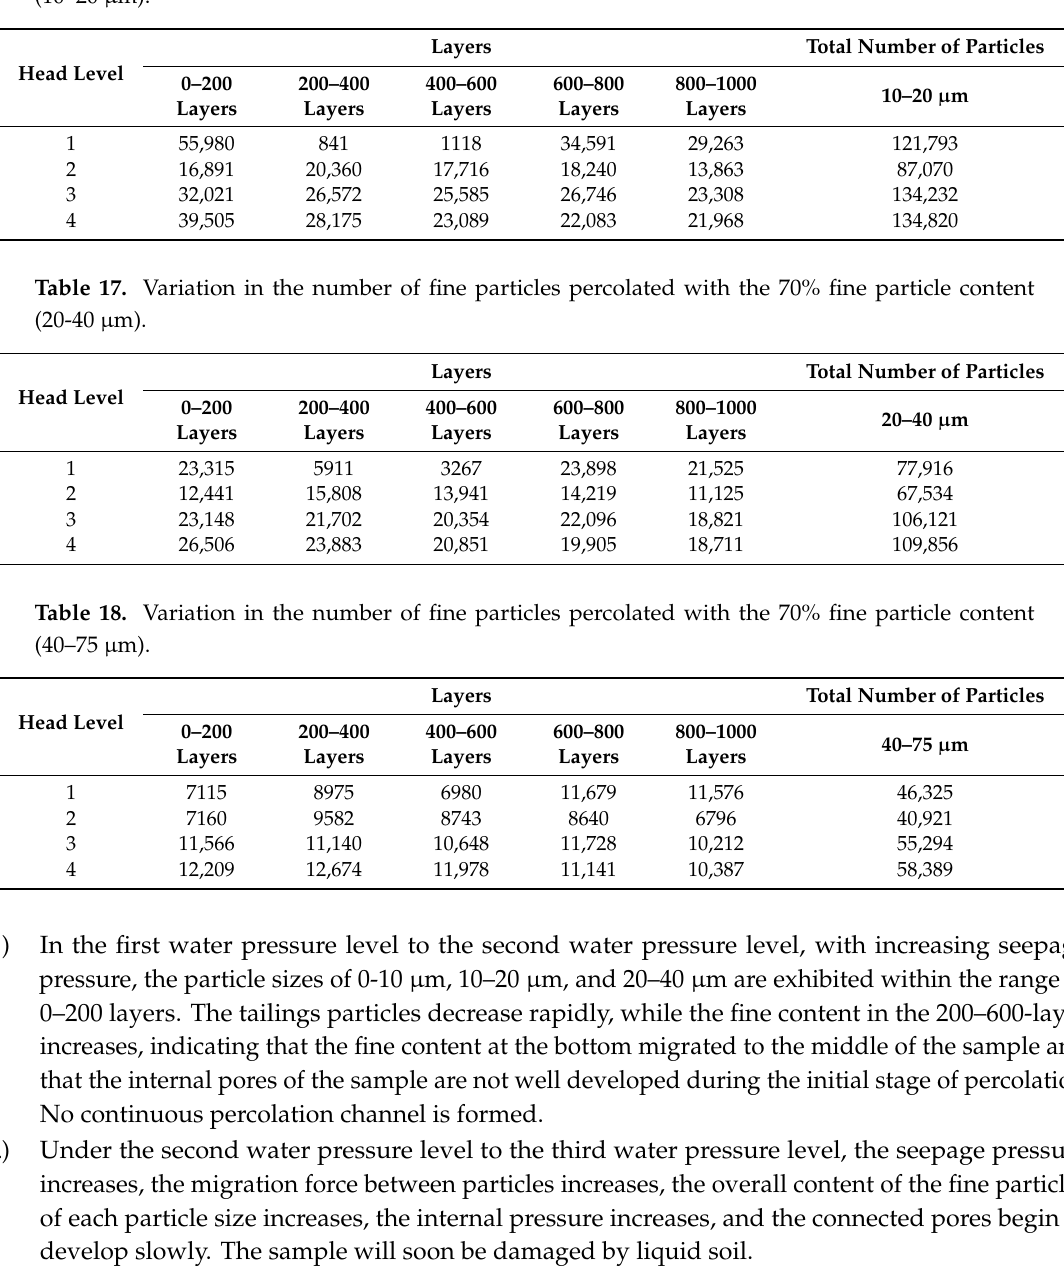
Table 16. Variation in the number of fine particles percolated with the 70% fine particle content (10–20 µ m).